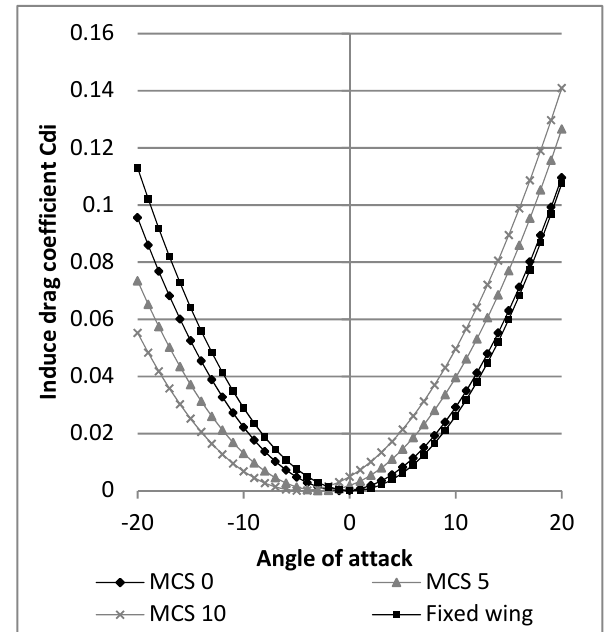
Figure 22. Induced drag coe ffi cient Cd i variation with the angle of attack.